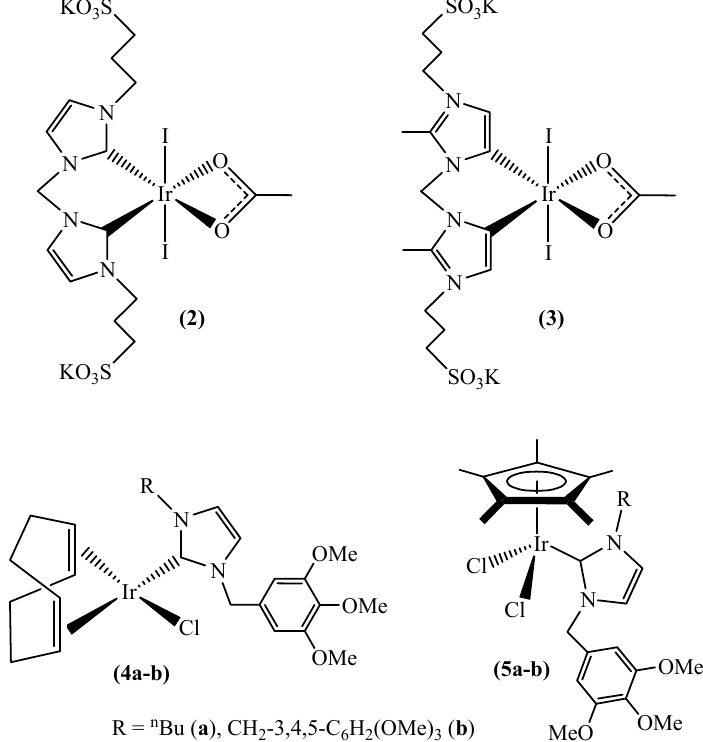
Figure 2. Structure NHC-based iridium catalysts 2 – 5